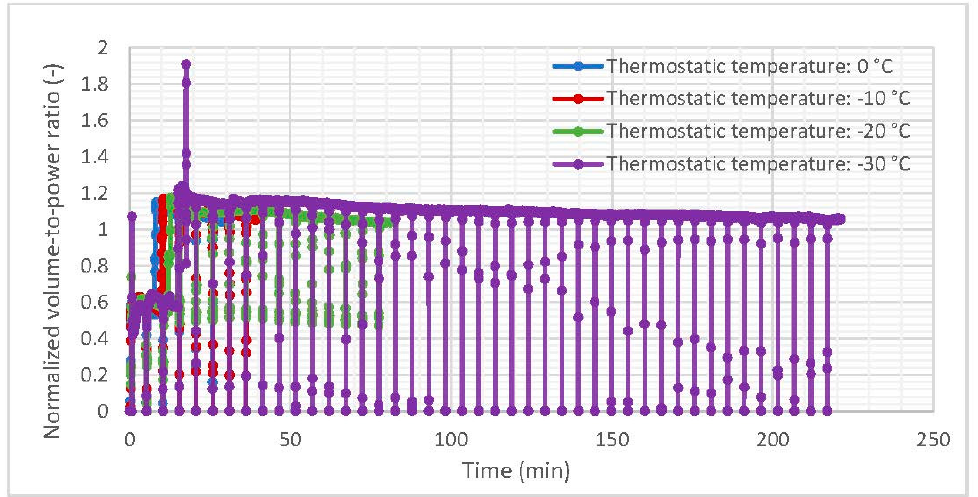
Figure 7. Normalized volume-to-power ratio averaged over the two tests executed for the diverse thermostatic temperatures. Table 2. Main results averaged after the closing of the anti-condensation valve that recirculates com- pressed and hot air, when the oil temperature reaches 50 °C.